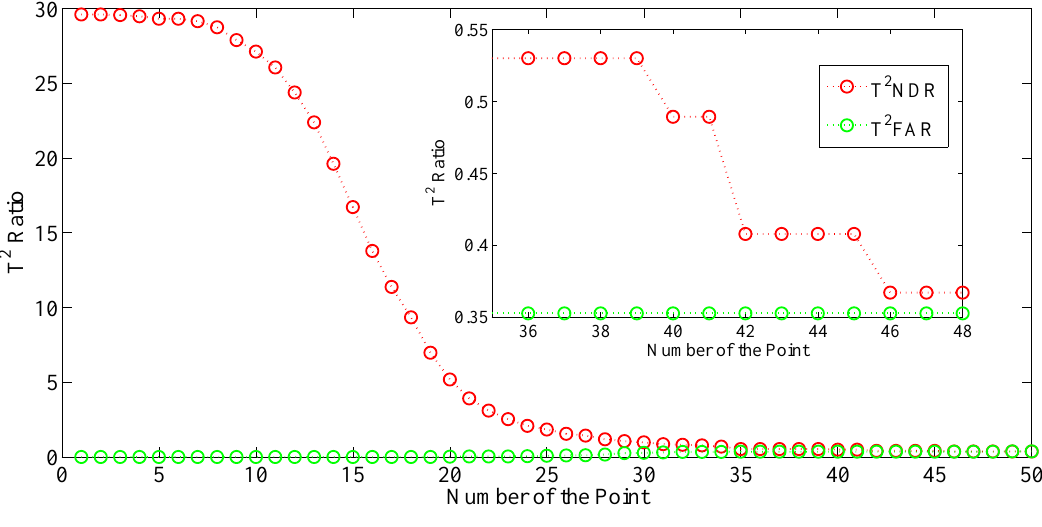
Figure 7. Fault detection results for f 3